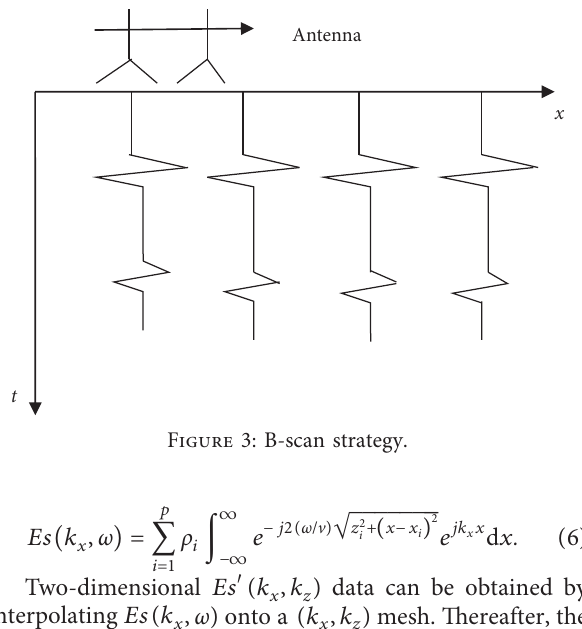
Figure 3: B-scan